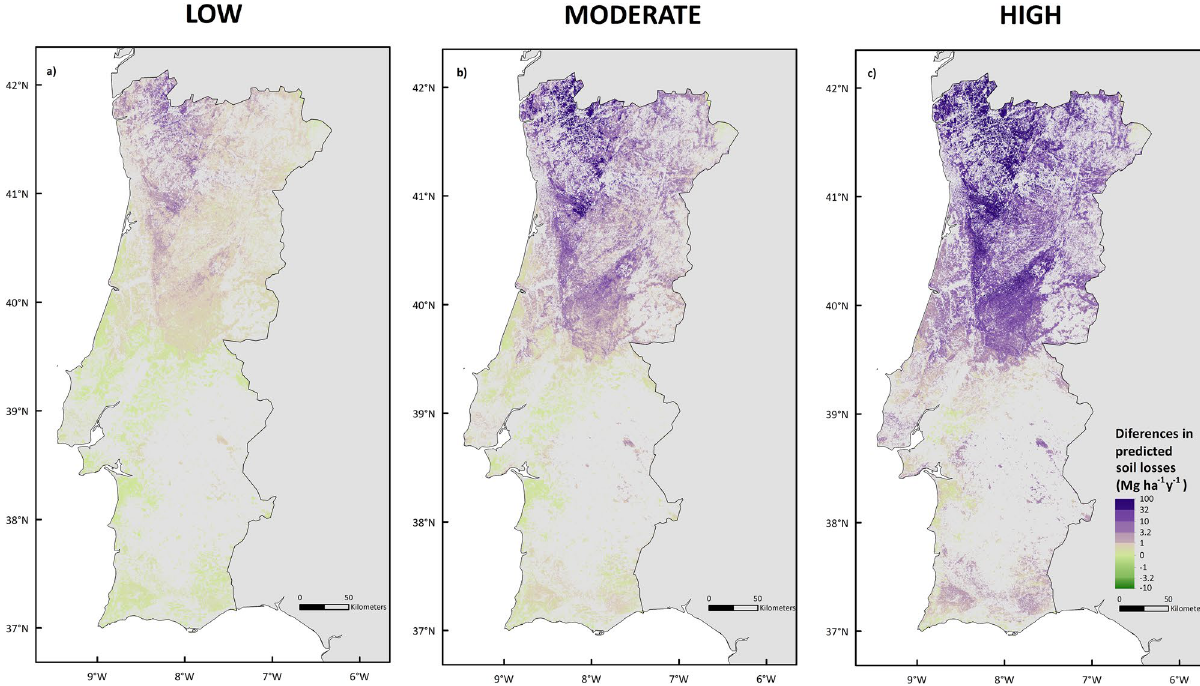
Figure 6. Maps of the differences between the soil losses (Mg ha −1 y −1 ) predicted for the year 2001 comparing the ERA-Interim and ERA5 rainfall datasets for three burn severity scenarios (low, moderate, and high), according with quantile